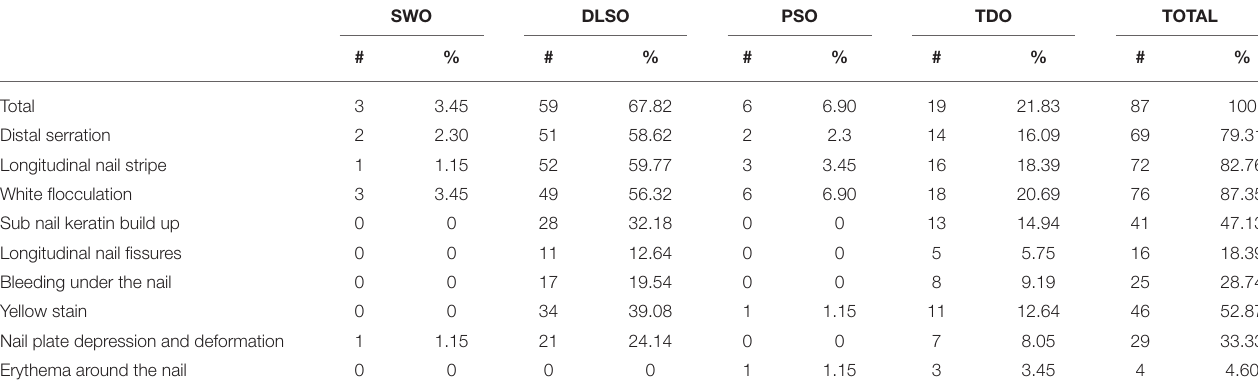
Erythema around the nail